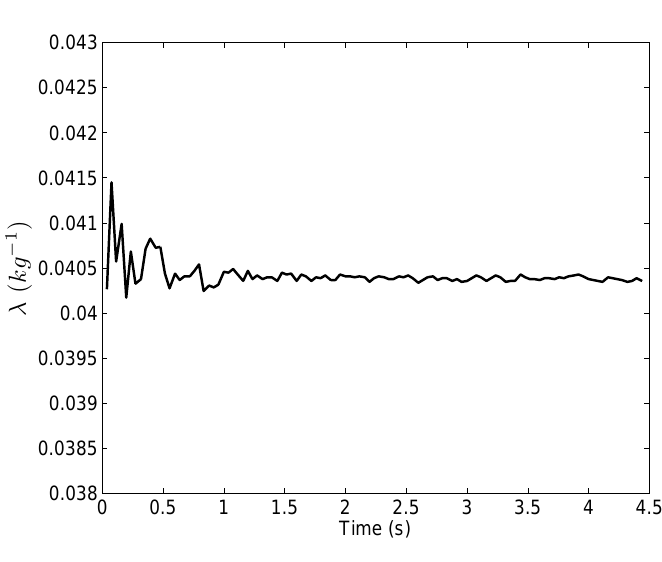
Figure 13. Estimate of λ